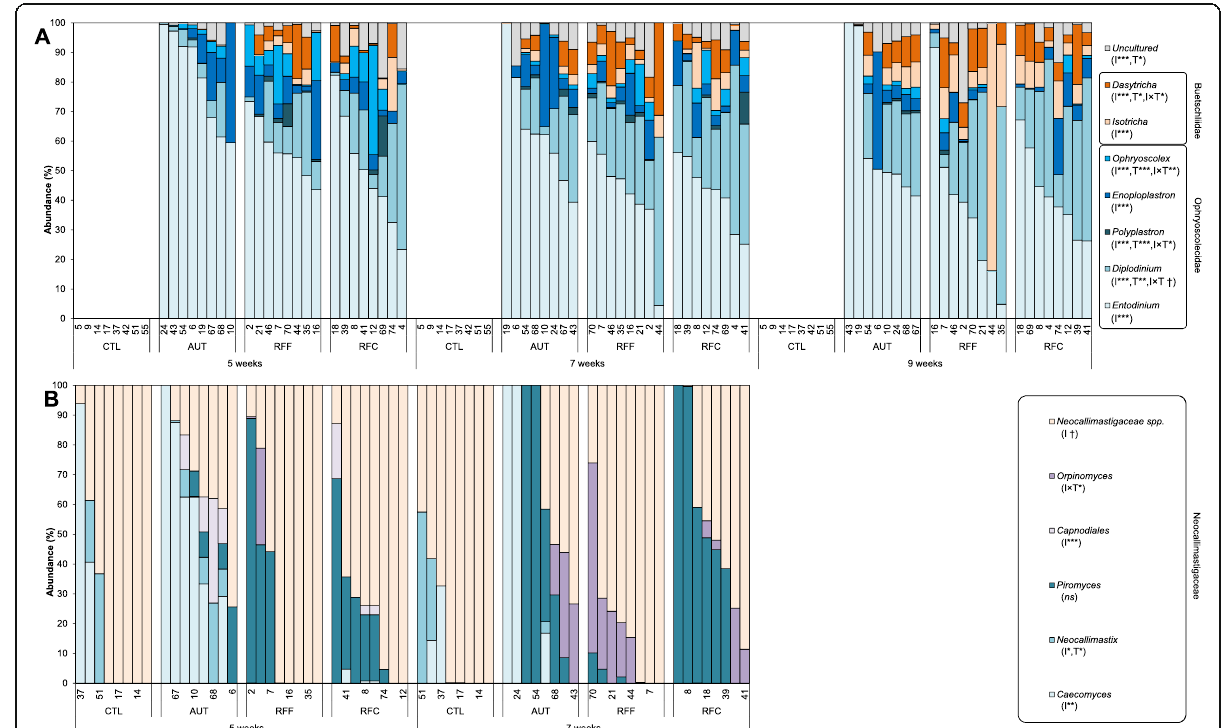
Fig. 6 Effect of the early-in-life rumen microbial inoculation on the rumen eukaryotic taxa distribution. A) Protozoa and (B) anaerobic fungi abundances. Goat kids inoculated (I) with fresh rumen fluid from adult goats adapted to forage-rich (RFF) or concentrate-rich diets (RFC), autoclaved rumen fluid (AUT) or absence of inoculation as control (CTL) and sampled at different times